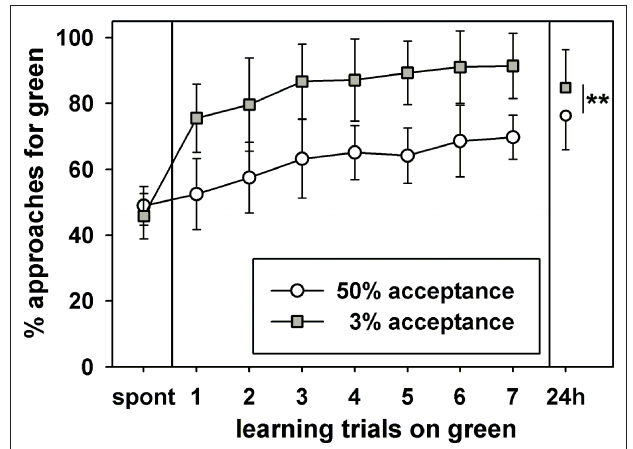
FiguRE 1 | Color learning experiment at an artificial feeder in the field for bees which either had acceptance thresholds ≤ 3% or ≥ 50%. The bees could choose between a green and blue alternative (for details see text). The abscissa shows the spontaneous choice (spont), choice tests after seven learning trials on green, and retention after 24 h (24 h). The ordinate shows the mean percentages of approaches with the respective standard deviations for the rewarded green alternative. The stars indicate significant differences of the choice reaction in the 24-h retention test (2-sided t -test, p < 0.01); other significant differences are not indicated in the figure, for details see text. 20 bees were tested in each group. Bees in the 50% acceptance group made between 4 and 17 approaches in the tests, resulting in a total of 3143 approaches for this group. Bees in the 3% acceptance group made between 5 and 17 approaches in the tests, resulting in a total of 3370 approaches for this